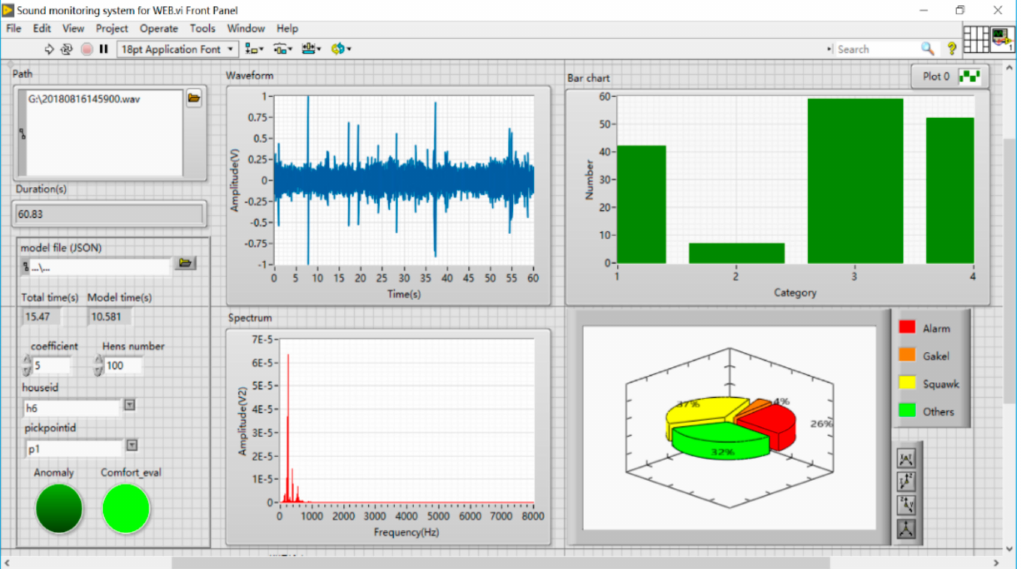
Figure 7. LabVIEW panel of the sound monitoring system for